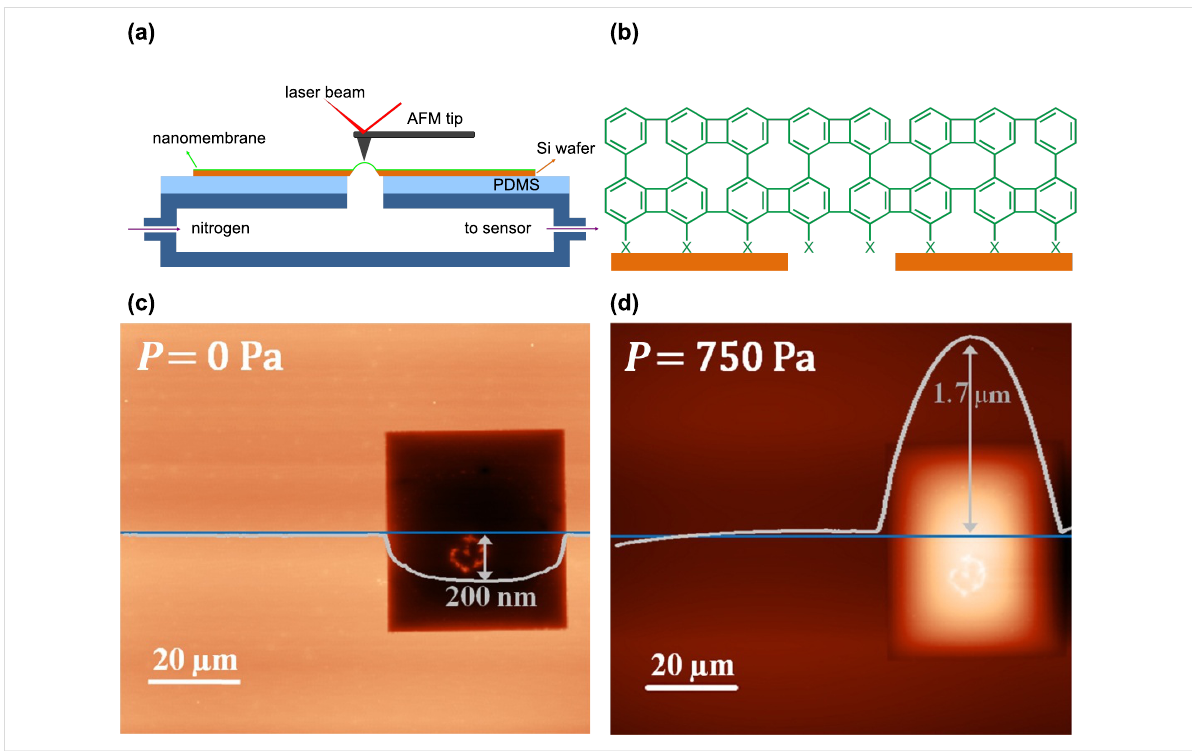
Figure 1: (a) Schematic diagram of a bulge test in AFM; (b) Schematic of a biphenylthiol CNM on a window-structured Si substrate, which is suspended over an orifice; (c) AFM image of a nonpressurized CNM in contact mode and the line profile with a downward deformation of 200 nm; (d) AFM image of the same membrane with an applied pressure of 750 Pa and a line profile with an upward deflection of 1.7 μ